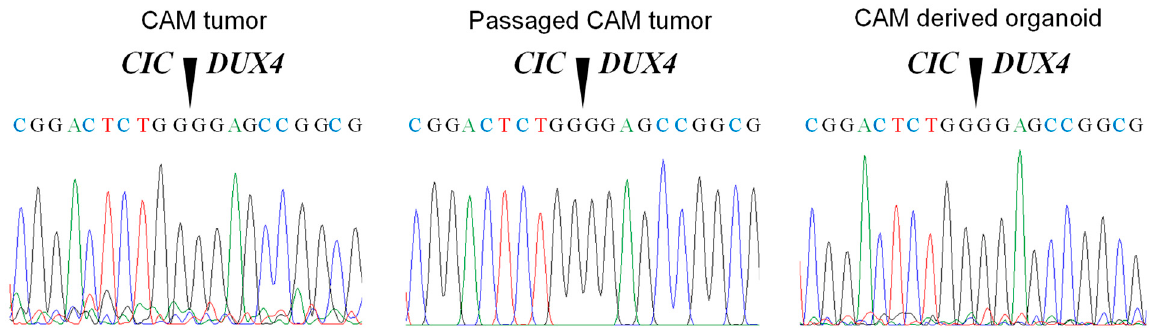
Figure 7. Detection of the CIC-DUX4 gene in the CAM tumor, passaged CAM tumor and in the CAM-derived tumor organoids.